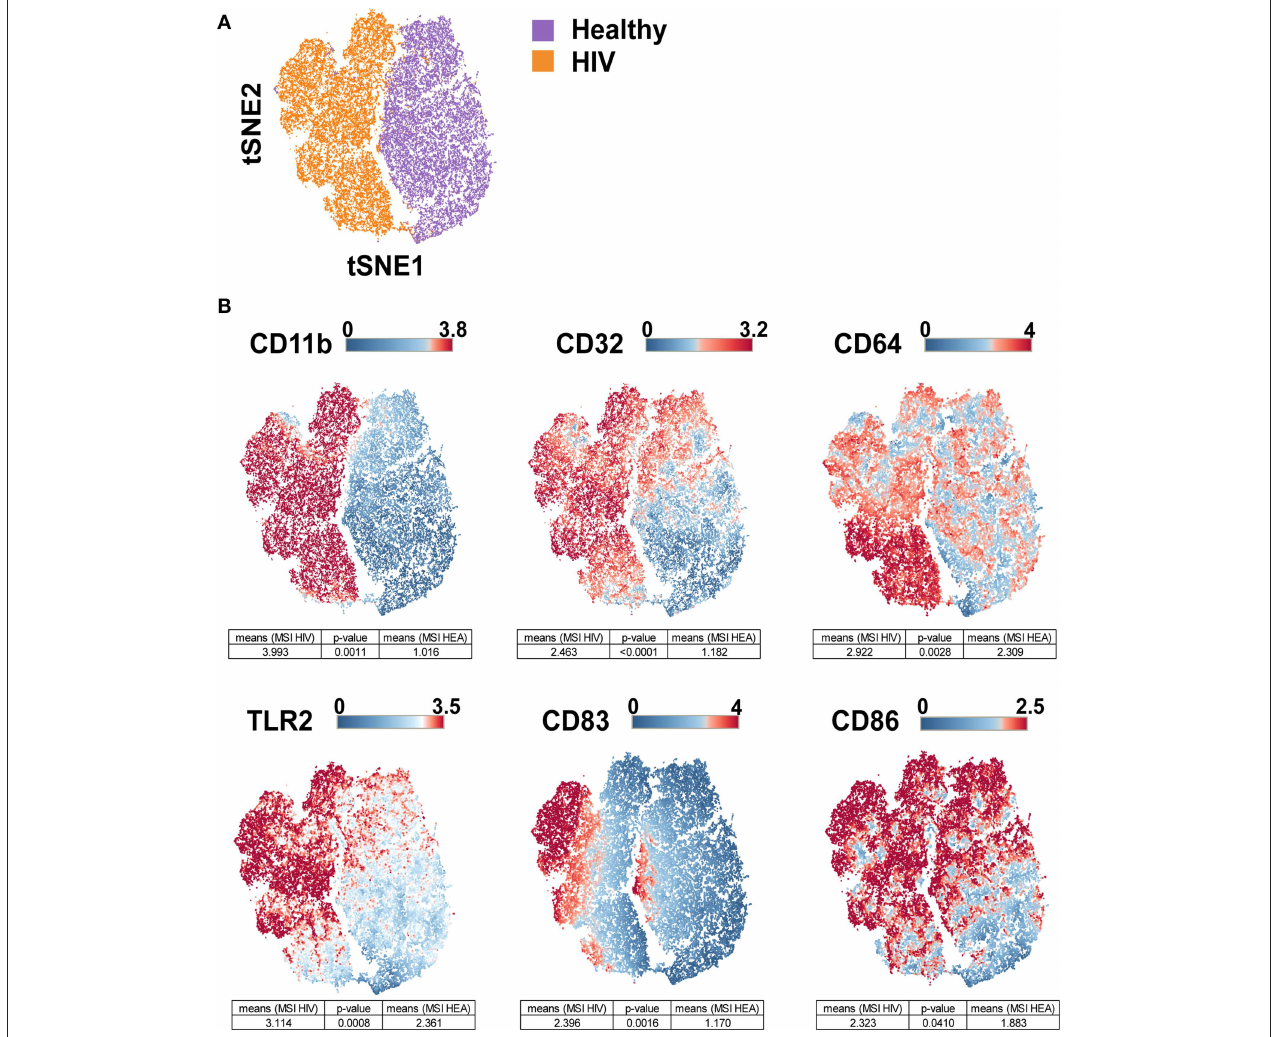
FIGURE 3 | viSNE map representing the phenotype of leukocytes from HIV-infected patients and healthy donors using a single antibody panel. Leukocytes from the three original HIV-infected subjects, three new HIV-infected patients, and six new healthy subjects were collected. SPADE analysis was performed to isolate monocytes. Monocyte cells were computationaly distributed into a two-dimensional space using the viSNE algorithm. Such viSNE representations were generated based on the expressions of CD11b, CD32, CD64, CD83, CD86, and TLR2. (A) The viSNE map is colored to represent cells from HIV-infected patients in orange and those from healthy individuals in purple. (B) The viSNE map is colored to represent the mean marker expression (MSI) of CD11b, CD32, CD64, CD83, CD86, and TLR2 for each cell. Comparisons of the MSIs from the individual groups were performed using non-parametric permutation